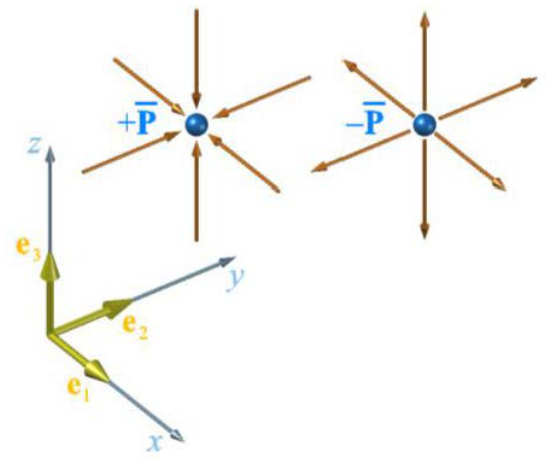
Figure 15: Positive and negative inner orientations of a point.